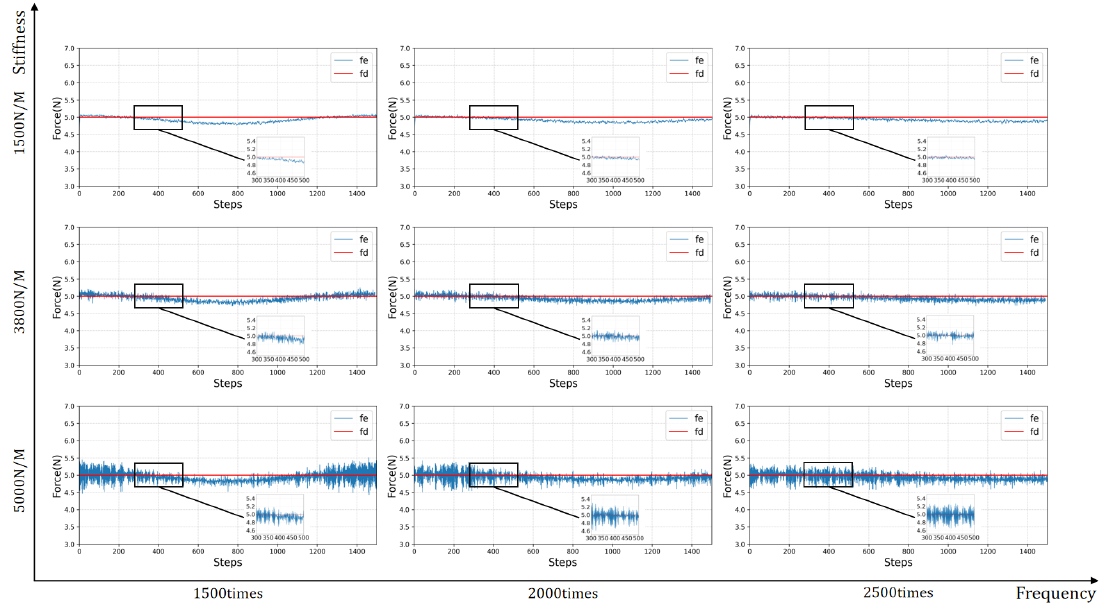
Figure 9. Performance testing. By changing the stiffness and frequency of the contact surface, the trained model is tested. The results show that the model has good